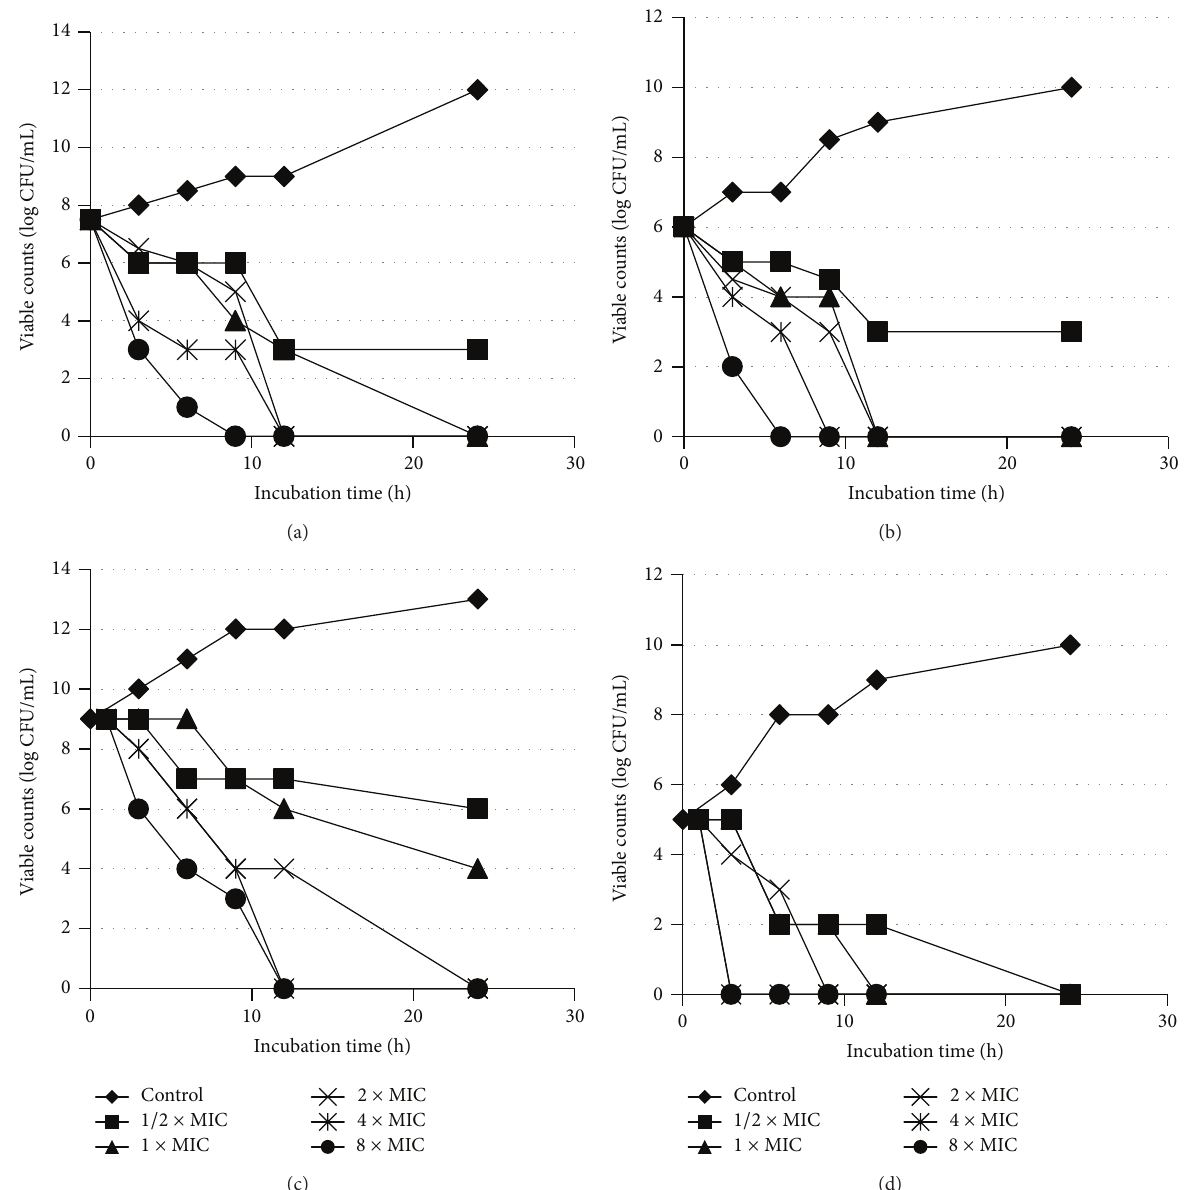
Figure5:Time-anddose-dependentkillingcurvesfor(a)silvernanoparticles,(b)tetracycline,(c)metronidazole,and(d)amoxicillin,against H. pylori strain NCTC